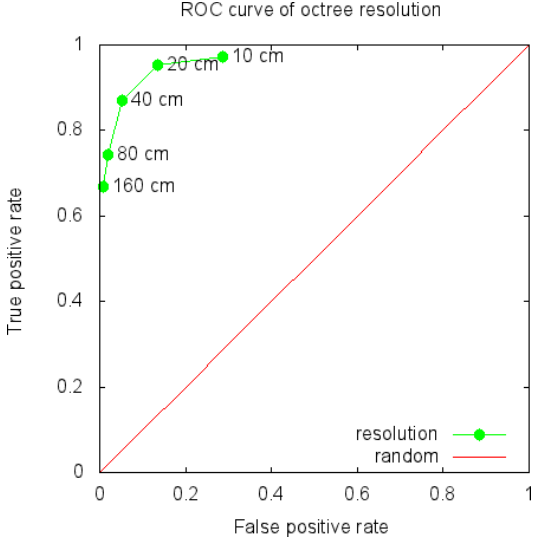
Figure 5. ROC curve describing the evaluation results depending on the resolution of the octree.